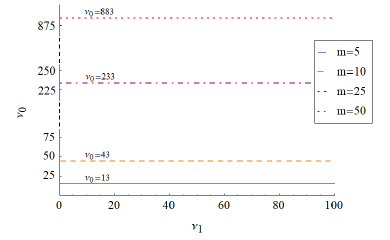
Figure 12. Boundary lines for comparison of T 2 and T 9